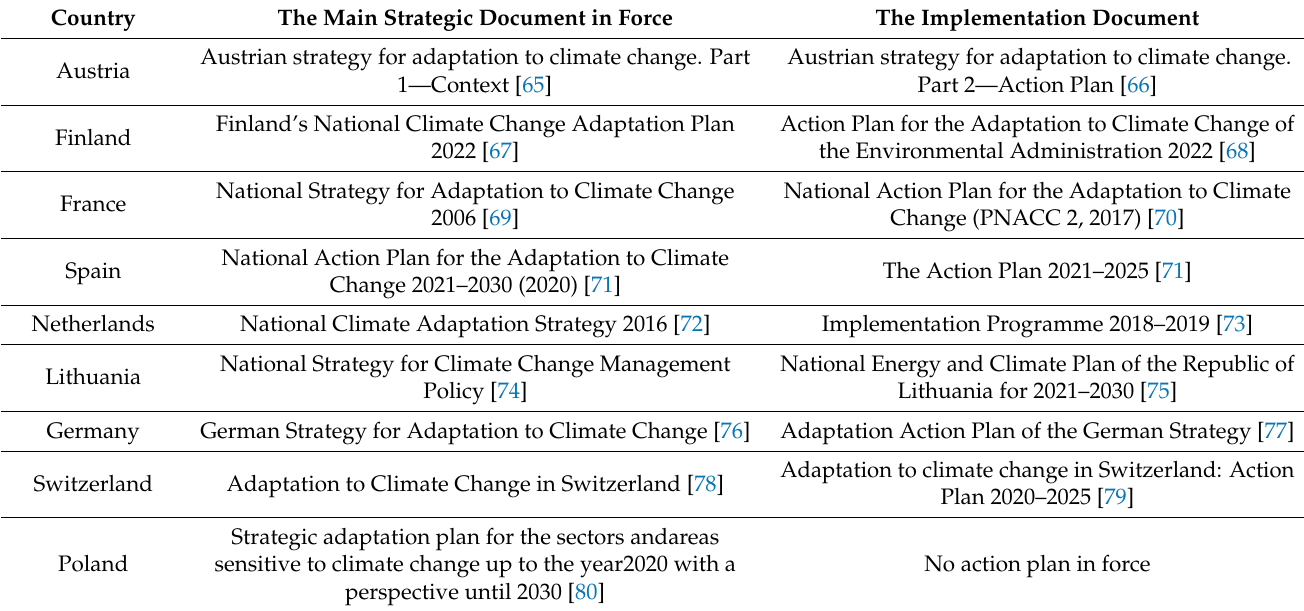
Table 1. Overview of the national adaptation strategic documents covered in the